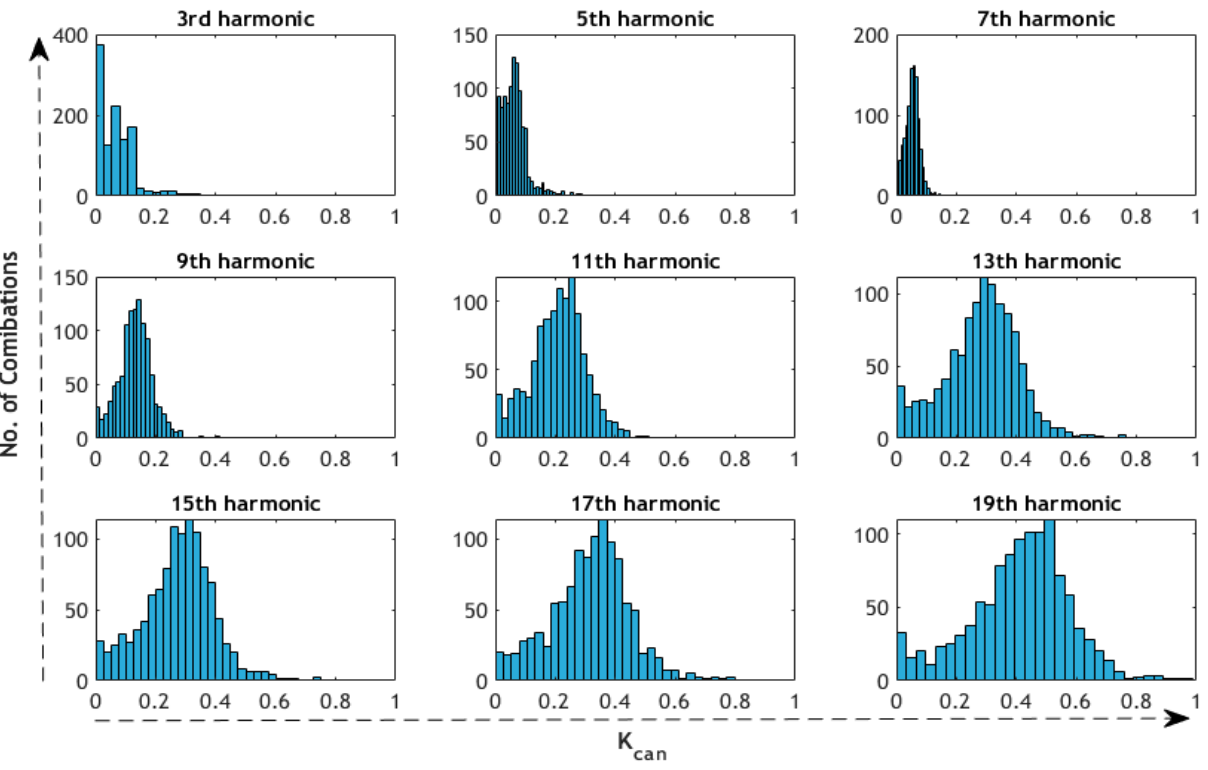
Figure 8. Harmonic cancellation effect of LED loads (no. of load scenarios/combinations on y-axis and cancellation coefficient on the x-axis) (number of combinations reported).